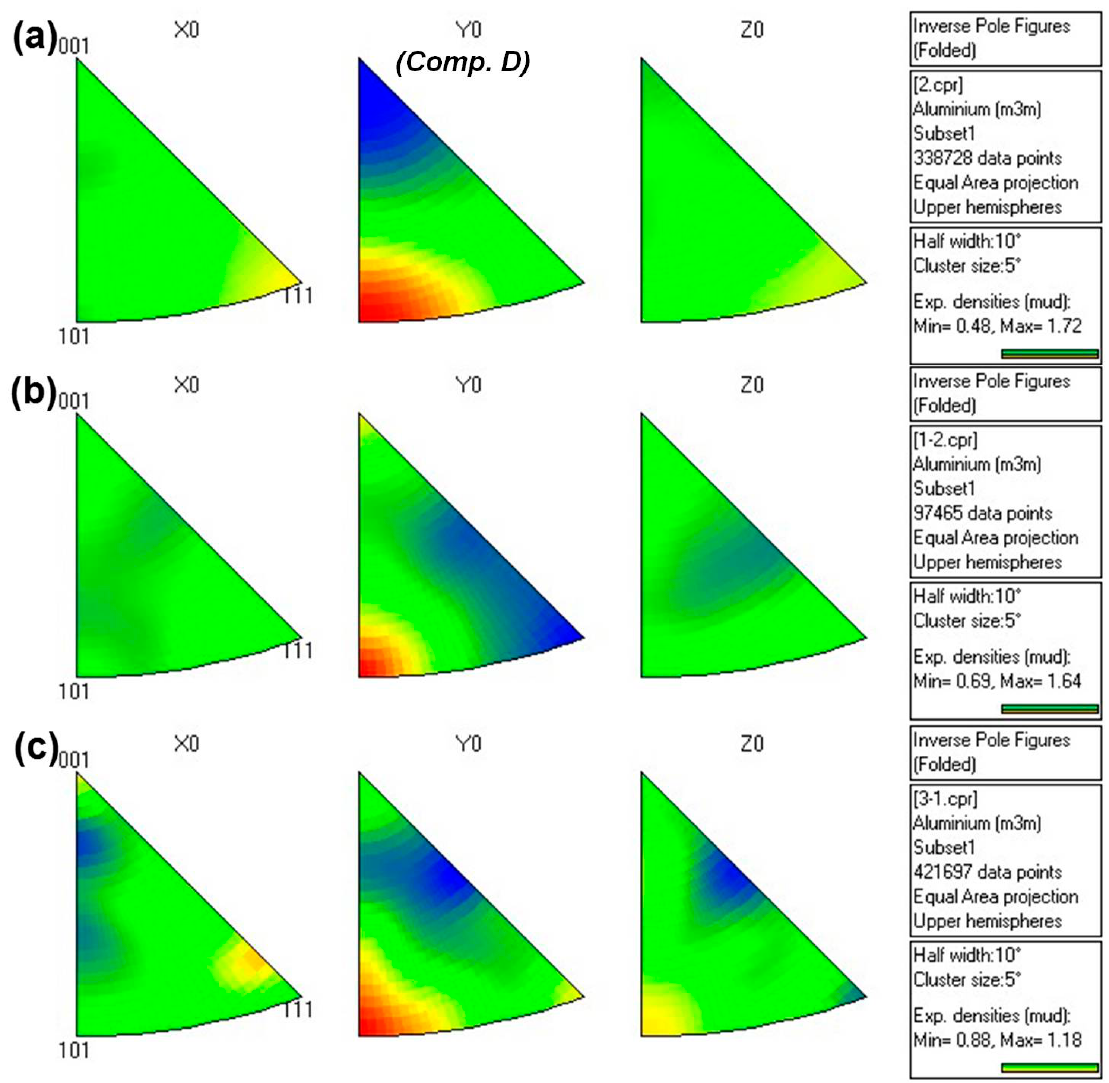
Figure 12. Inverse pole figure of γ phase for the alloy prior to ( a ) and after compression deformation under 1000 °C with the strain rate of 10 − 2 s − 1 ( b ) and 10 − 4 s − 1 ( c ).